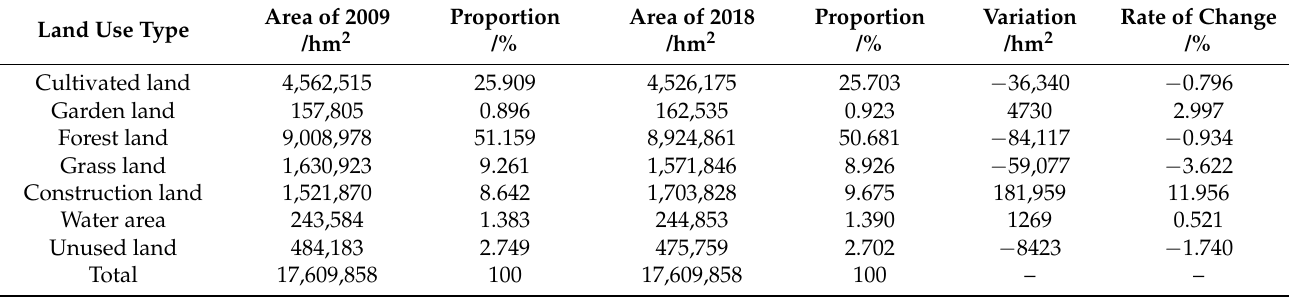
Table 3. Changes of the land use area in Guizhou Province in 2009 and